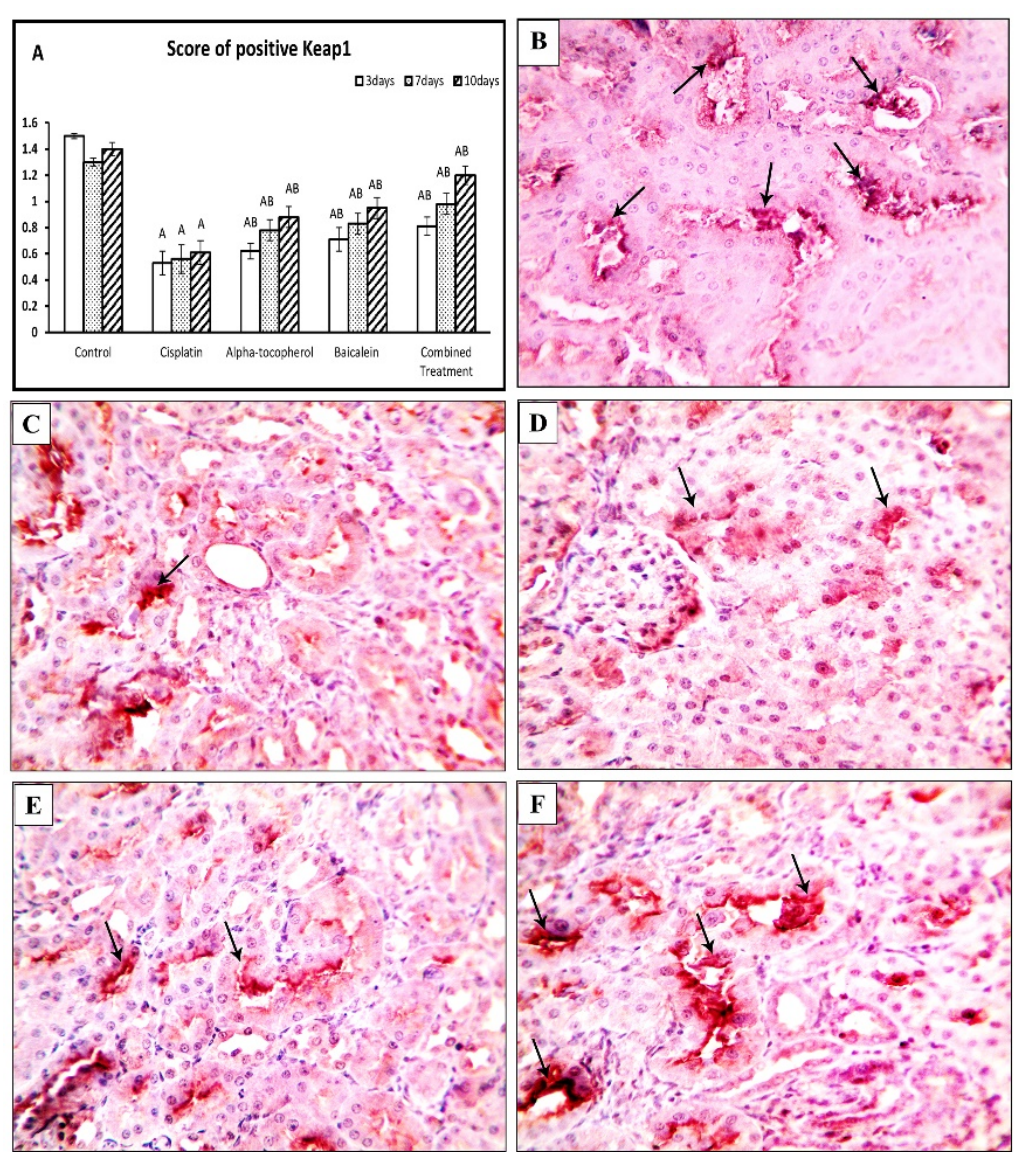
Figure 10. Microscopic pictures of adrenal sections immunostained against Keap-1 from rat groups sacrificed after 10 days showing ( A ) positive cell score, significant vs. control group refers to A, while significant vs. (cisplatin, -tocopherol, and baicalein) treatment groups refers to (B, C, D), respectively, ( B ) control group with marked Keap-1 expression, and ( C ) mild expression in positive brown tubular expression in Cisplatin group. ( D ) The positive brown tubular expression slightly increased in renal sections from the α -tocopherol group, ( E ) moderately increased in renal sections from the baicalein group, and ( F ) significantly increased in renal sections from the combined treatment group. Black arrows indicate positive reaction. IHC counterstained with Mayer’s hematoxylin. High magnification ×: 400 bar 50.